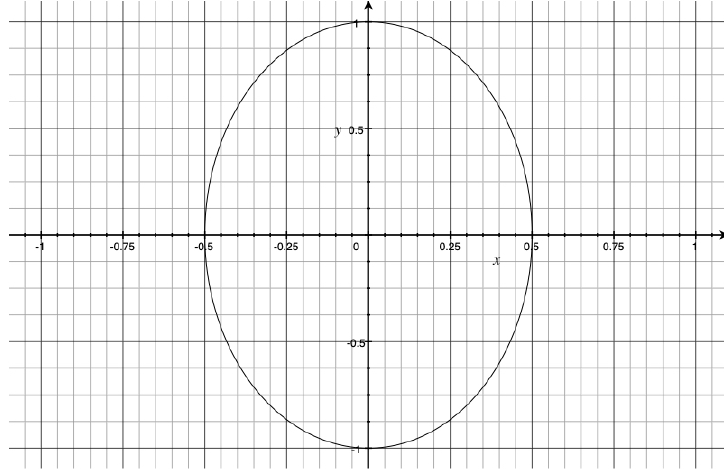
Figure 5. Workspace representation of Equation (11) planar incision